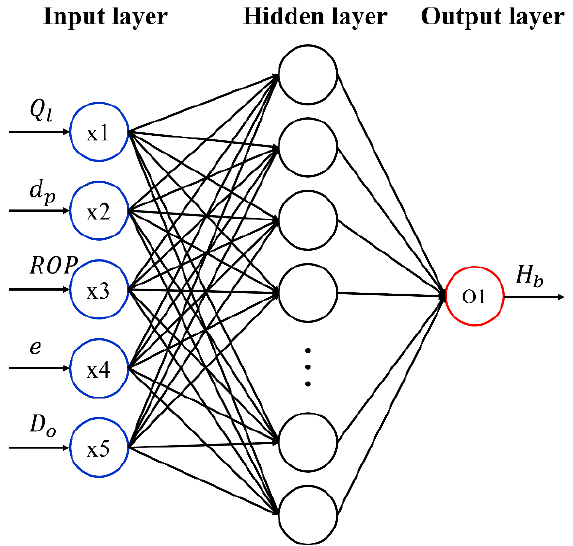
Figure 1. The schematic of the ANN model ( 𝑄 𝑙 is the flow rate of drilling fluids ( m 3 /s ), 𝑑 𝑝 is the cuttings diameter ( m ), 𝑅𝑂𝑃 is the rate of penetration ( m/s ), 𝑒 is the eccentricity, 𝐷 𝑜 is the well- bore diameter ( m ), 𝐻 𝑏 is the cuttings bed height ( m )).